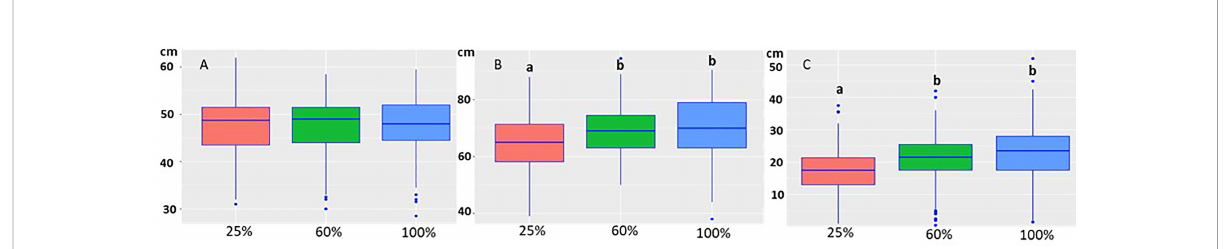
FIGURE 3 Boxplot of the height of the seedlings at the start of the experiment (A) , at the end of the experiment (B) under different water treatments (25%, 60% and 100%). The height of the seedlings was not statistically different at the start of the experiment in the different water treatments (A) . At the end of the experiment the height was statistically lower in the 25% treatment (B) . (C) The growth decrease was statistically signi fi cant in the 25% water group compared to 60% and 100% treatments. The letters indicate the statistical